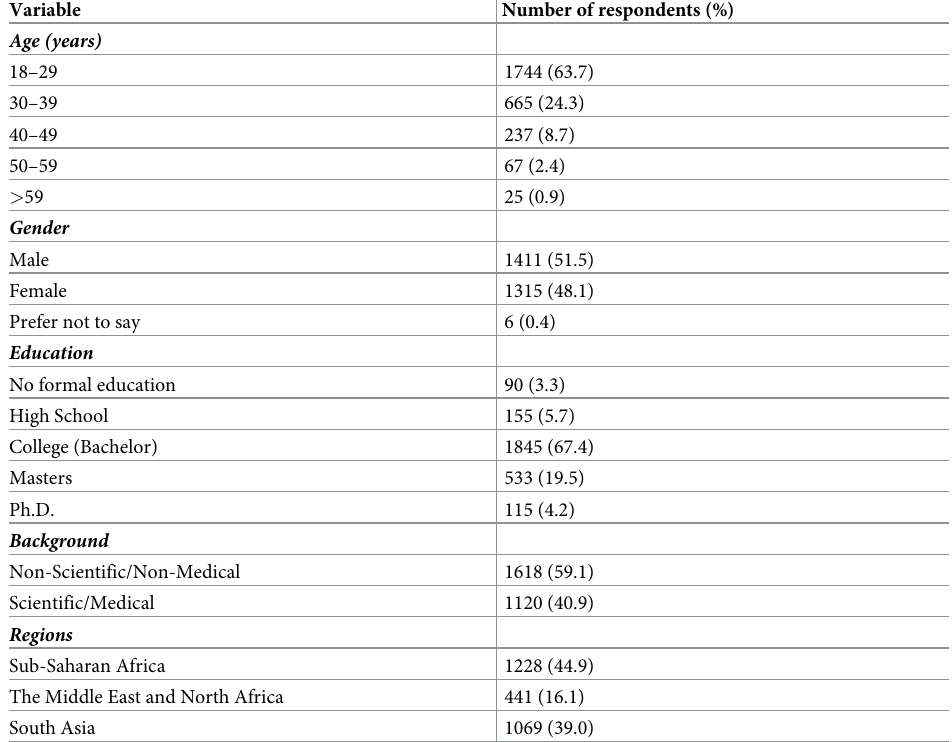
Table 1. Demographics of respondents from Sub-Saharan Africa, the Middle east, and North Africa and South Asia (n = 2738).